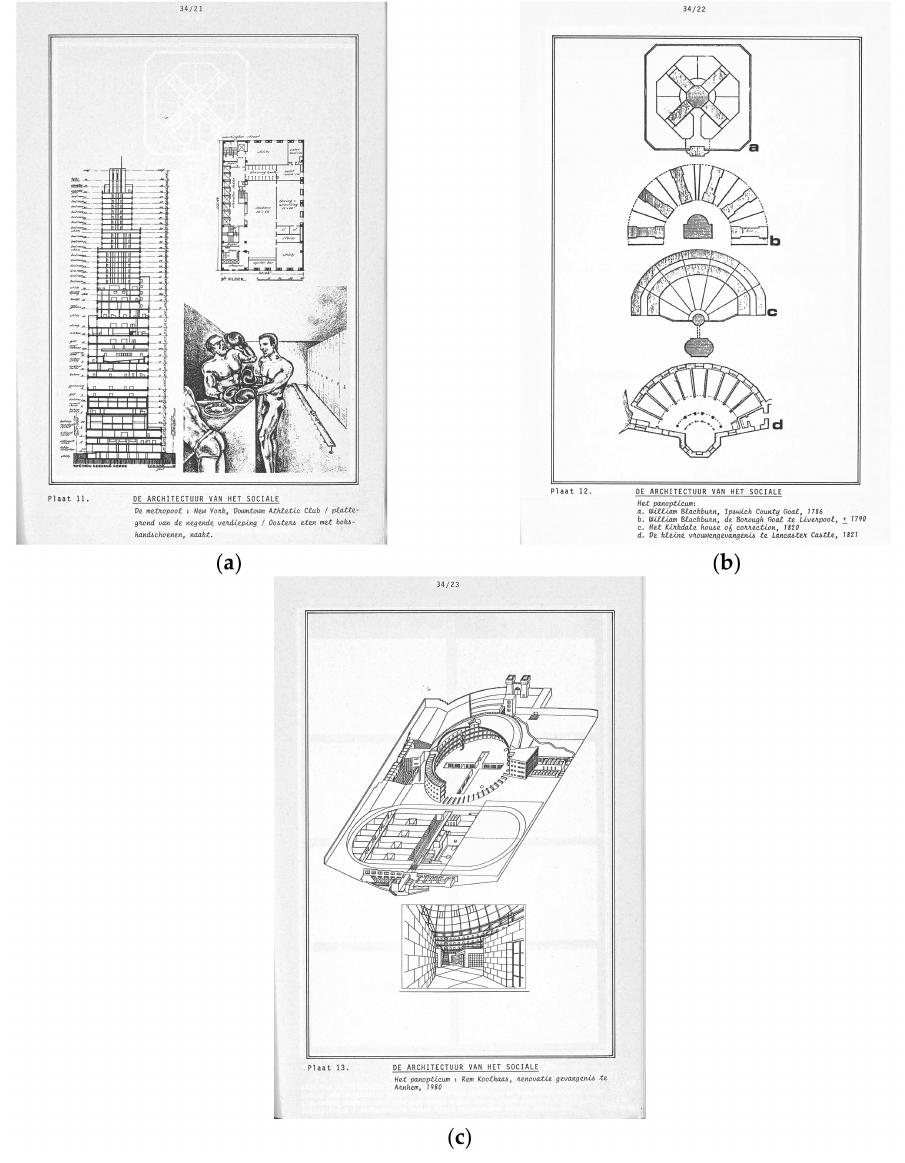
Figure 6. Images of the lecture Een ontwerp voor de gevangenis te Arnhem (A design for the prison in Arnhem)byR.Koolhaas, 1980, at TUDelft . ( a )PlaatXI.“Themetropolis”; ( b )PlaatXII.“ThePanopticon”; ( c ) Plaat XIII. “The Panopticon: Rem Koolhaas, prison renovation in Arnhem,